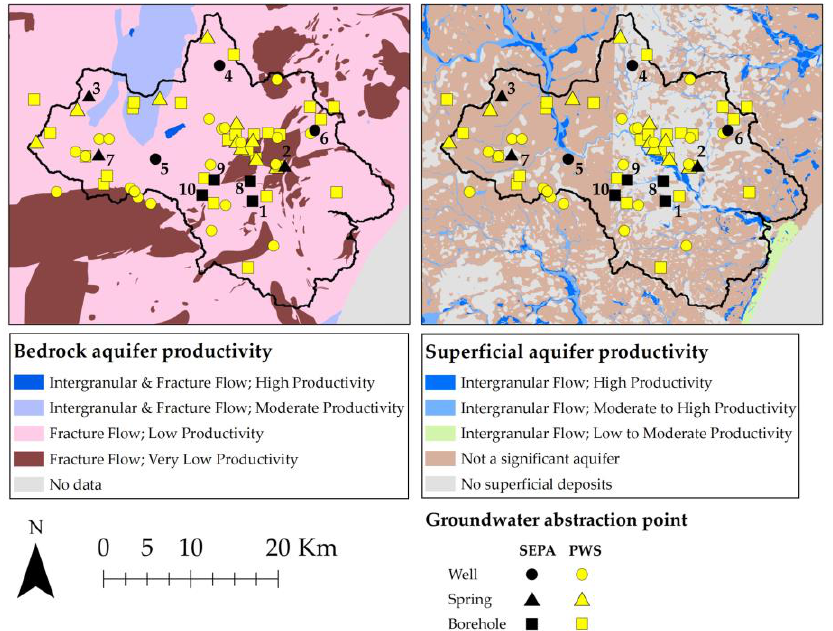
Figure 2. Spatial distribution of SEPA groundwater quality monitoring stations 1–10 and Private Water Supply (PWS) groundwater sampling points by construction type (well, spring, borehole) overlayed onto BGS aquifer productivity (Scotland) datasets derived from 1:100,000 scale BGS Digital Data under License (2023/007) British Geological Survey. © and Database Right UKRI. All rights reserved